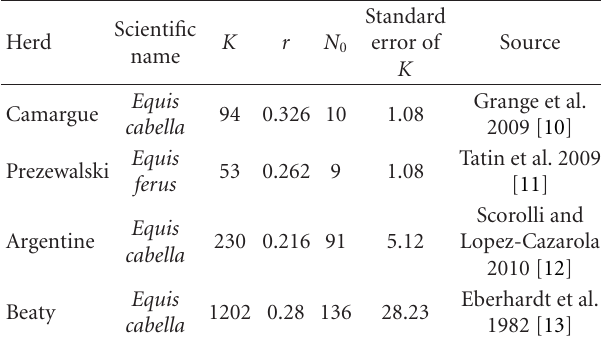
Table 2: Data on horse herds.